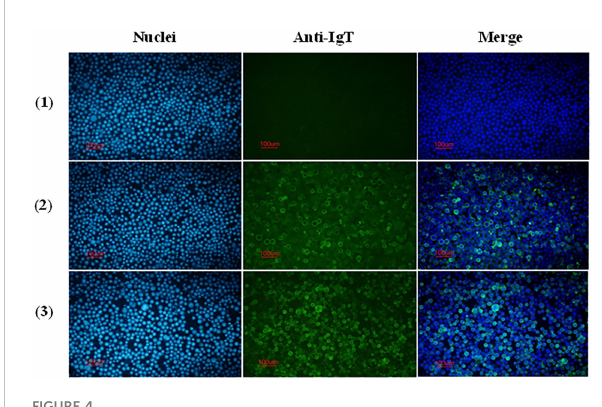
FIGURE 4 Reactivity of anti-CH2-CH4 IgT antibodies with recombinant full- length IgT expressed in Sf9 III cells. Indirect immuno fl uorescence staining on control and Bac-IgT infected Sf9 III cells using mouse and rabbit anti-CH2-CH4 rIgT-speci fi c antibodies. Control Sf9 III (1) and Bac-IgT infected Sf9 III (2) cells stained with mouse anti-CH2-CH4 IgT antibody (green) and DAPI (blue). IgT-transfected Sf9 III cells (3) stained with rabbit anti-CH2-CH4 IgT antibody (green) and DAPI